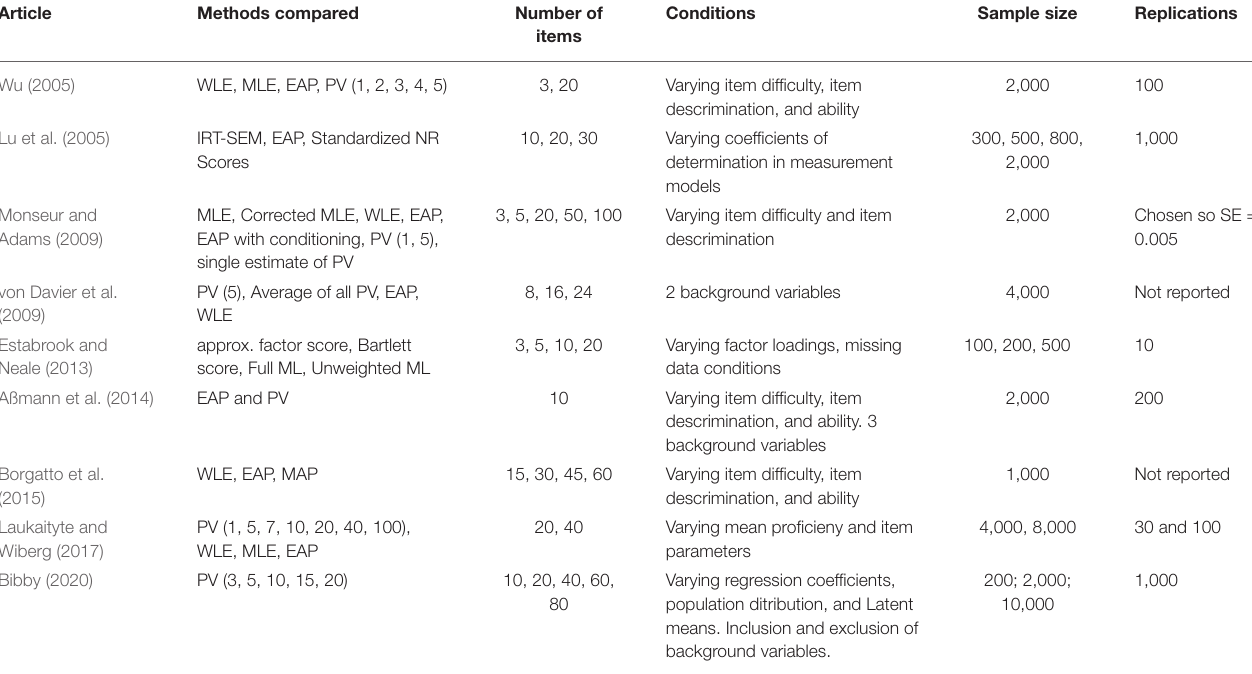
TABLE 2 | A brief summary of simulation study articles comparing different approaches to analyzing skills data in the context of cognitive